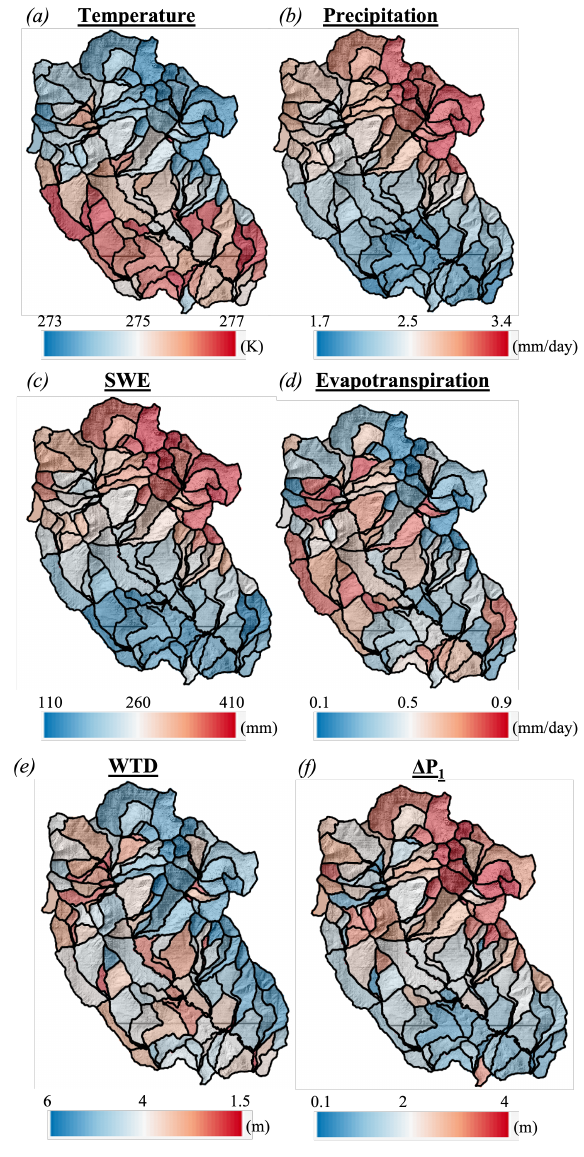
Figure 3. Spatial distributions of hillslope annual average values of (a) temperature, (b) precipitation, (c) snow water equivalent (SWE), (d) evapotranspiration, (e) water table depth (WTD) and (e) (cid:49)P 1 .